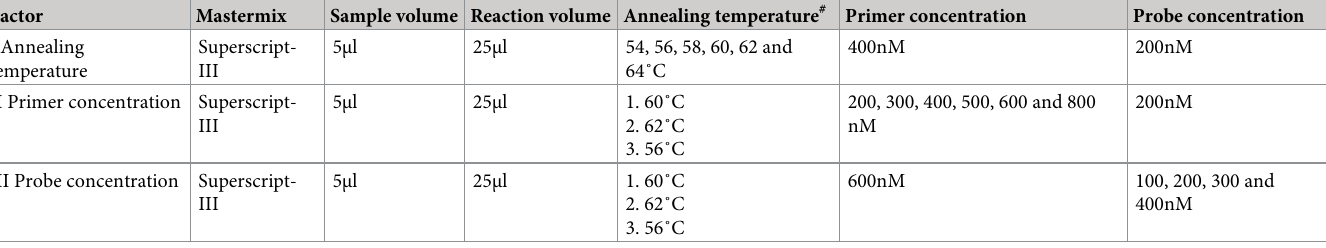
(cid:3) All experiments were performed with G1-1326 tenfold dilutions. # Annealing temperature for the Pyke, NS2A and NS3 systems were 60, 62 and 56˚C